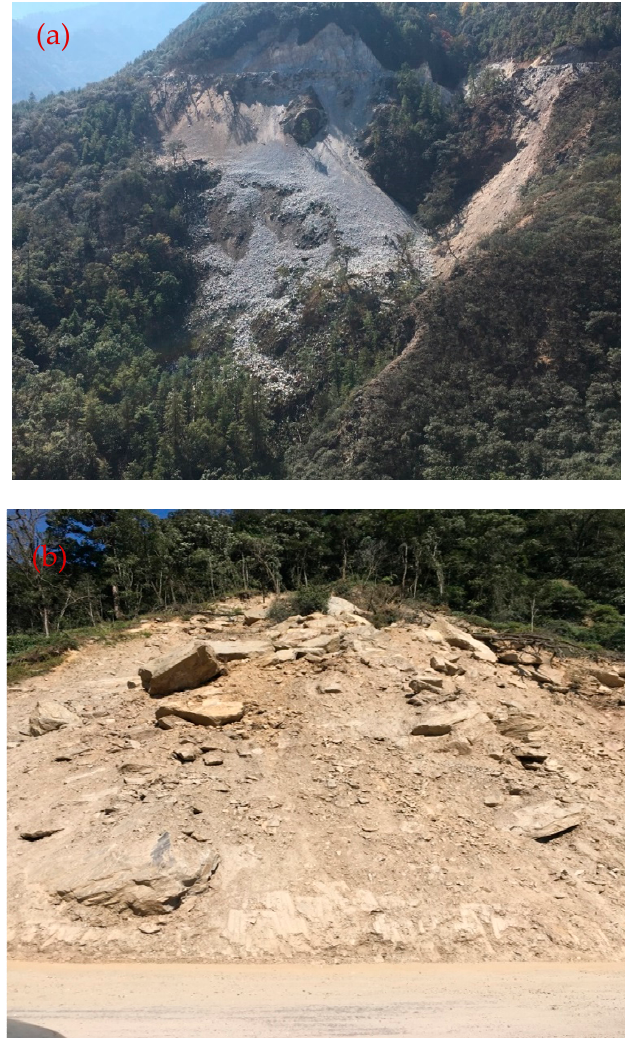
Figure 2. Landslide damages ( a ) near Chukha Dzongkhag ( b ) along the Phuentsholing–Thimphu highway.